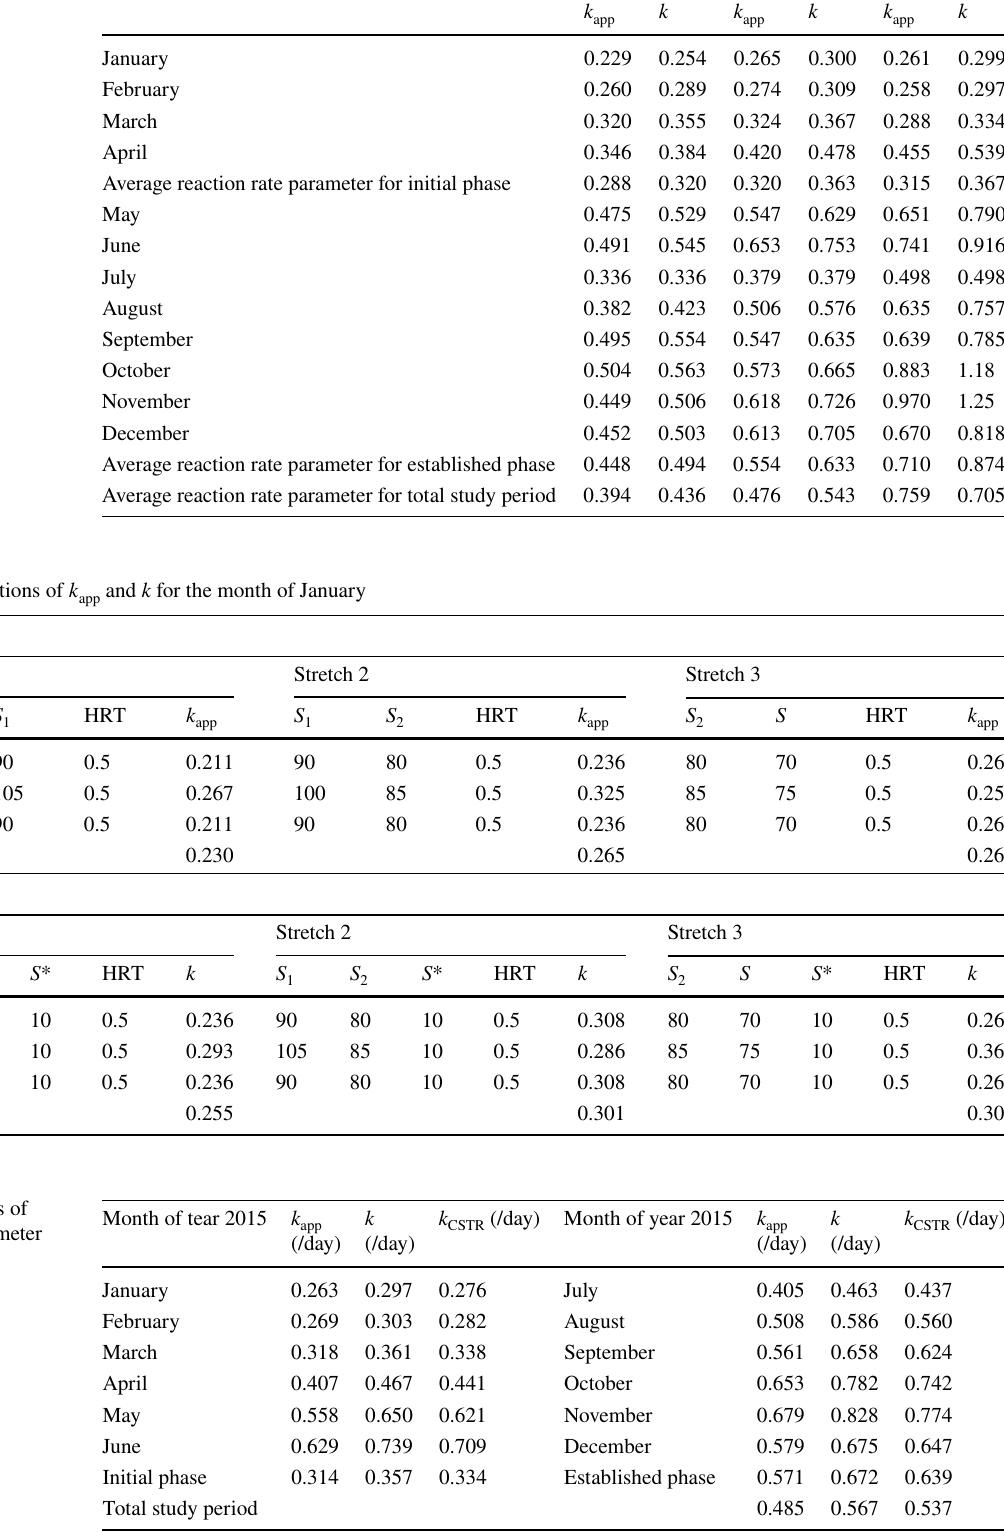
Table 3 Computed values of reaction rate parameters ( k app and k ) for three stretches